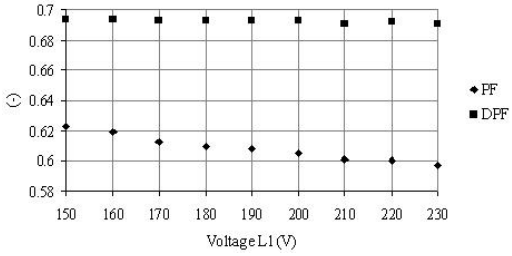
Figure 12. The unbalance factor for voltages V unb and currents I unb depending on supply voltage on phase a (set 3).